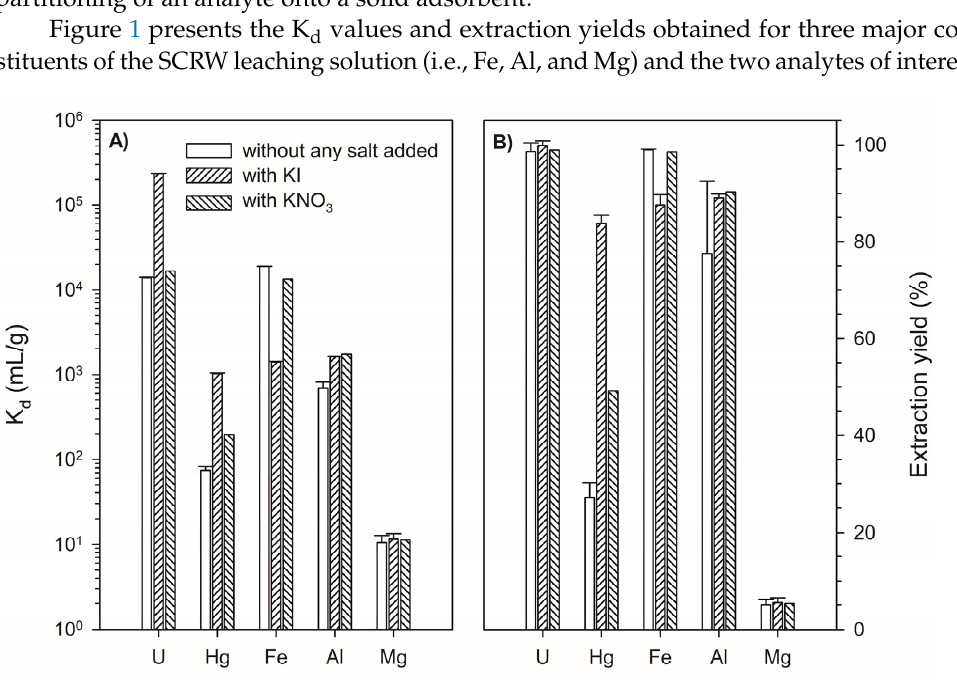
Figure 1. Distribution coefficient values ( A ) and extraction yield ( B ) of selected analytes on Lewatit TP260 at pH 1.8 (H 2 SO 4 media), without any salt added, with KNO 3 (0.15 M) and KI (0.15 M) (equilibration time, 24 h).